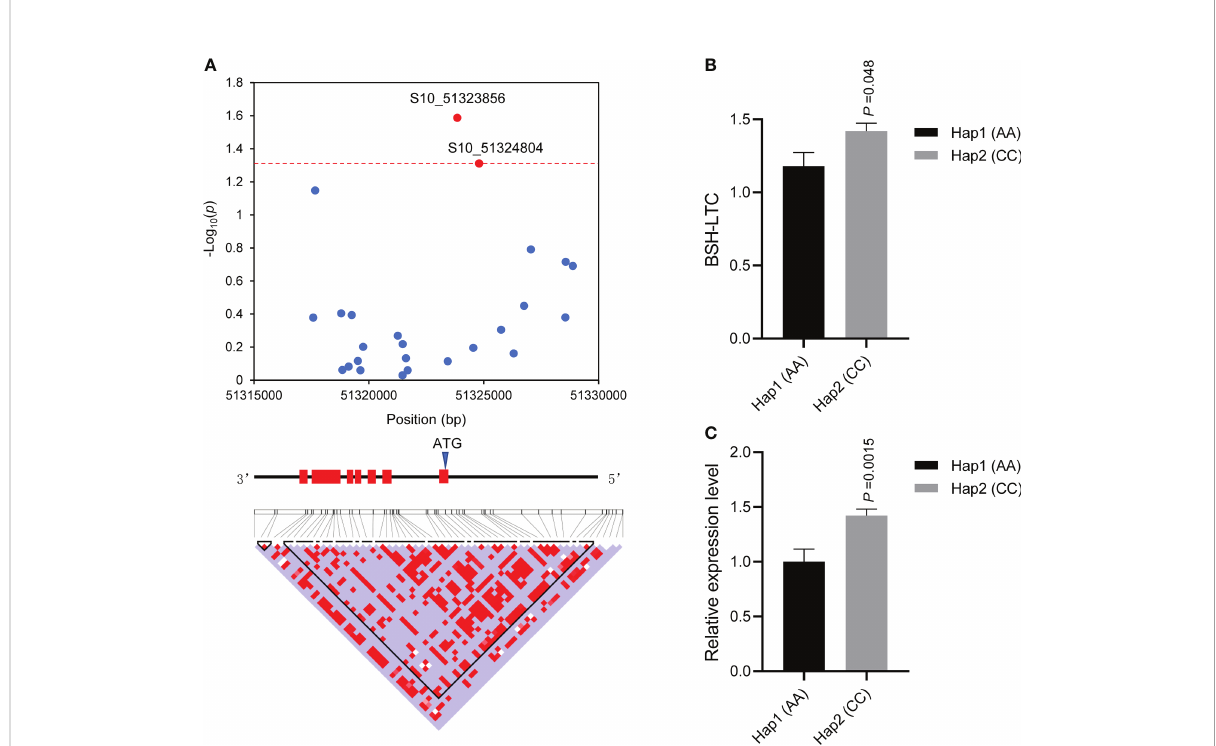
FIGURE 3 Association analysis of the candidate gene ZmbZIP107 . (A) The SNPs (S10_51323856 and S10_51324804) signi fi cantly (p < 0.05) associated with BSH-LTC. The dashed red line shows the signi fi cance threshold (p = 0.05). The gene simulation structure is shown in the middle and the red fi lled boxes represent the exons of ZmbZIP107 . The bottom image indicates the pairwise LDs (linkage disequilibriums) between the SNP markers. BSH, root bushiness; LTC, lead-tolerance coef fi cient. (B) Comparison of BSH-LTC between the two haplotypes, Hap1 (AA, n=12) and Hap2 (CC, n=46). (C) Comparison of ZmbZIP107 expression level between the two haplotypes under Pb